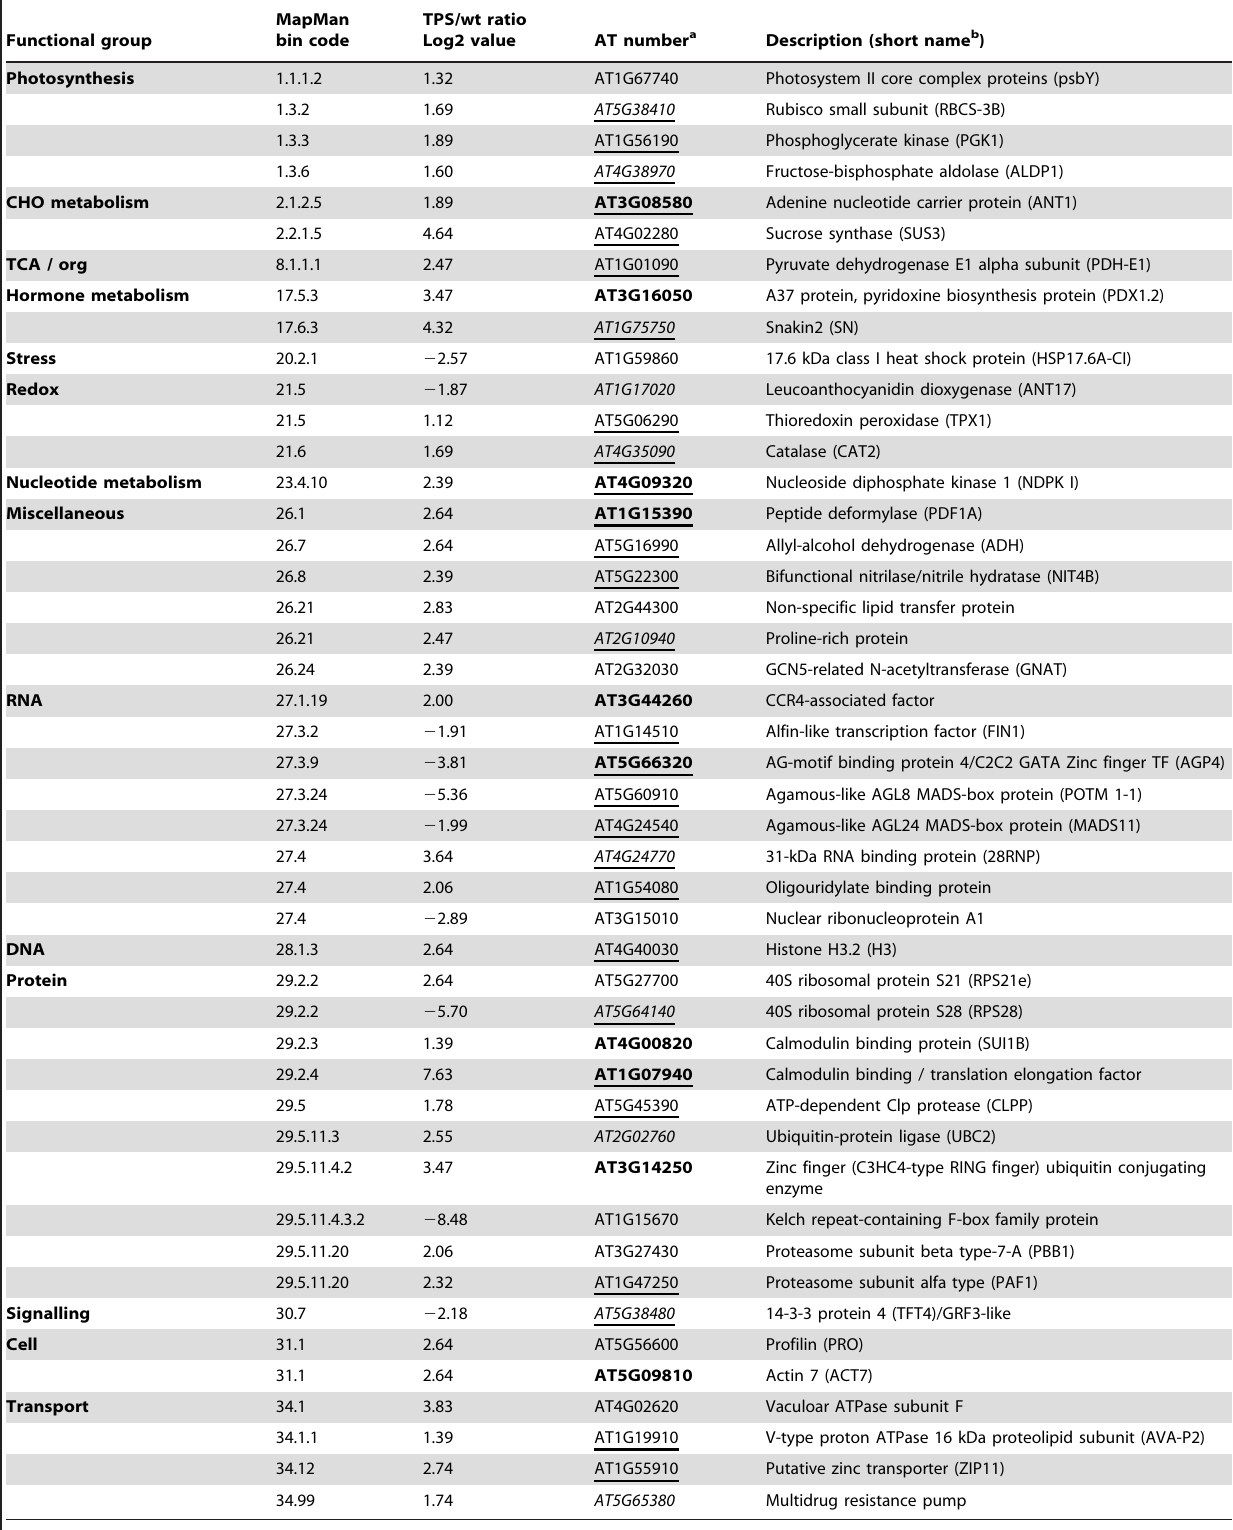
Table 2. Functional annotation of differentially expressed